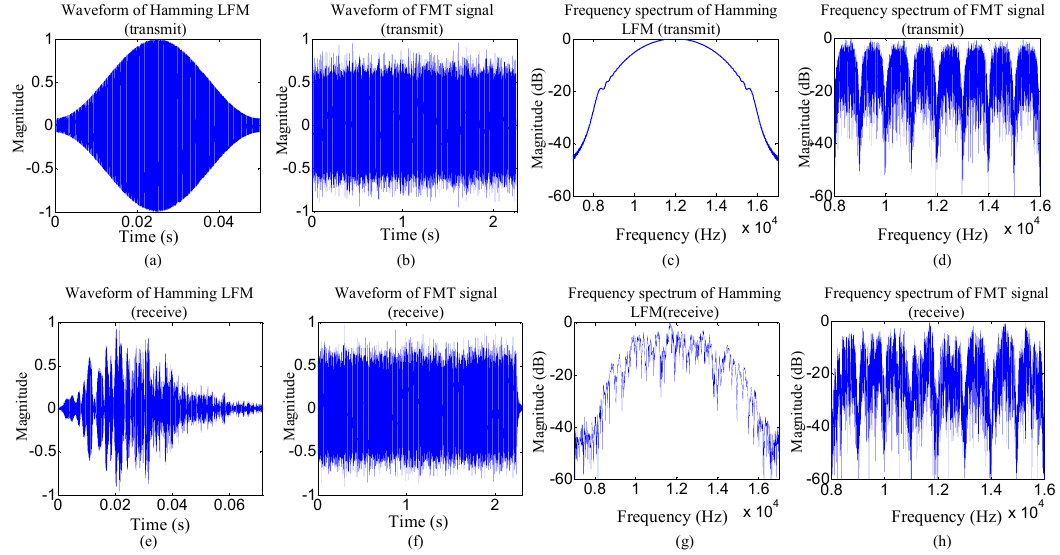
Figure 8. Time domain waveforms and frequency spectrums of linear frequency modulated (LFM) signals with a hamming window and FMT signals at the transmitter and the receiver on the condition of 8PSK mapping scheme used: ( a – d ) time domain waveforms and frequency spectrums of the LFM signal and the FMT signal at the transmitter; ( e – h ) time domain waveforms and frequency spectrums of the LFM signal and the FMT signal at the